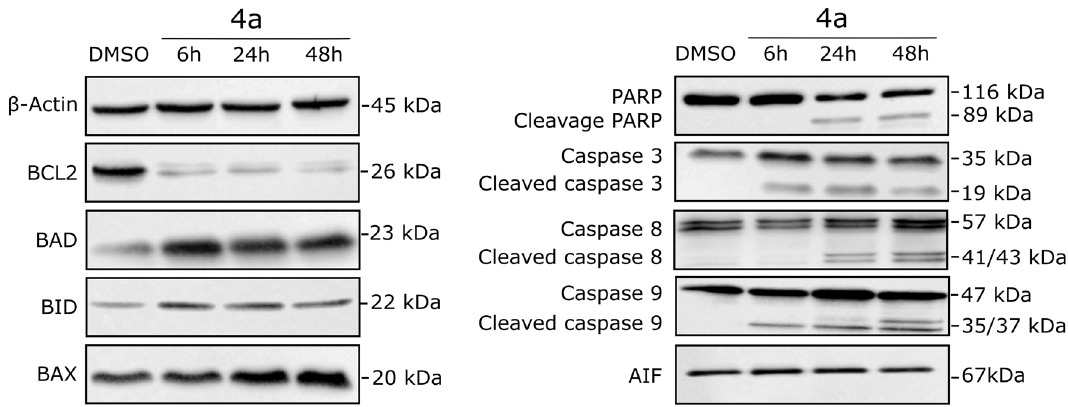
Figure 6. Western blotting analysis showing the effects of 4a on the expression of apoptosis-related proteins in the A549 cell line. Full-length Western blots are presented in the supplementary information.